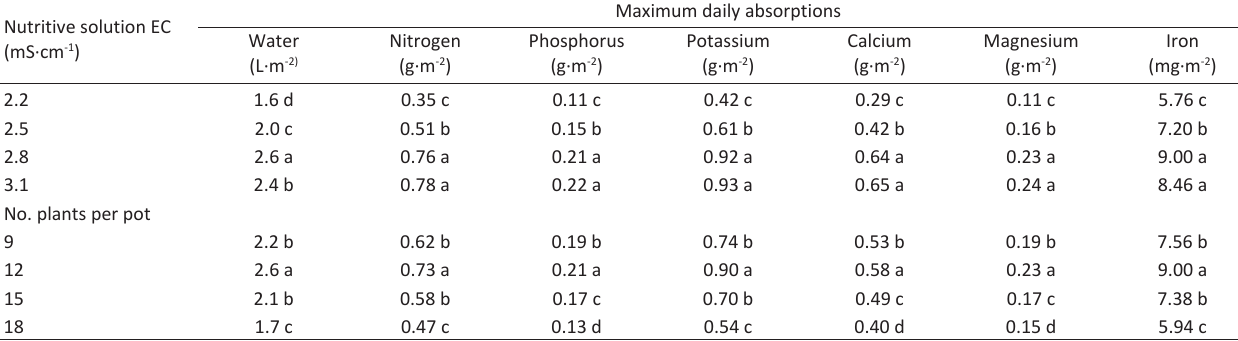
Table 4 - Basil water and nutrient absorptions Nutritive solution EC (mS·cm -1 )